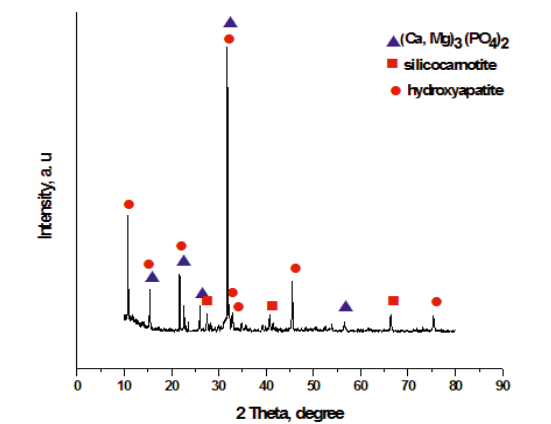
Figure 5. XRD of Ca-1 sample after immersion in 1.5 SBF for 1 day Figure 7. SEM of the Ca-1 sample after thermal treatment at 1200°C/2 h